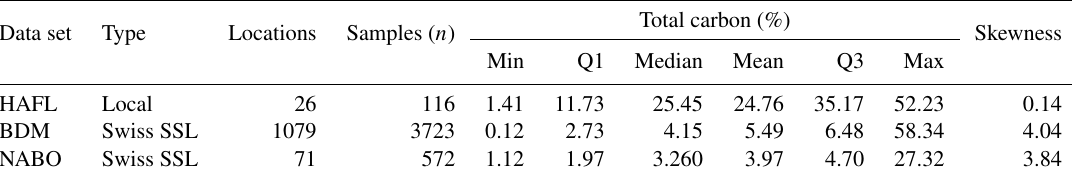
Data set Type Locations Samples ( n